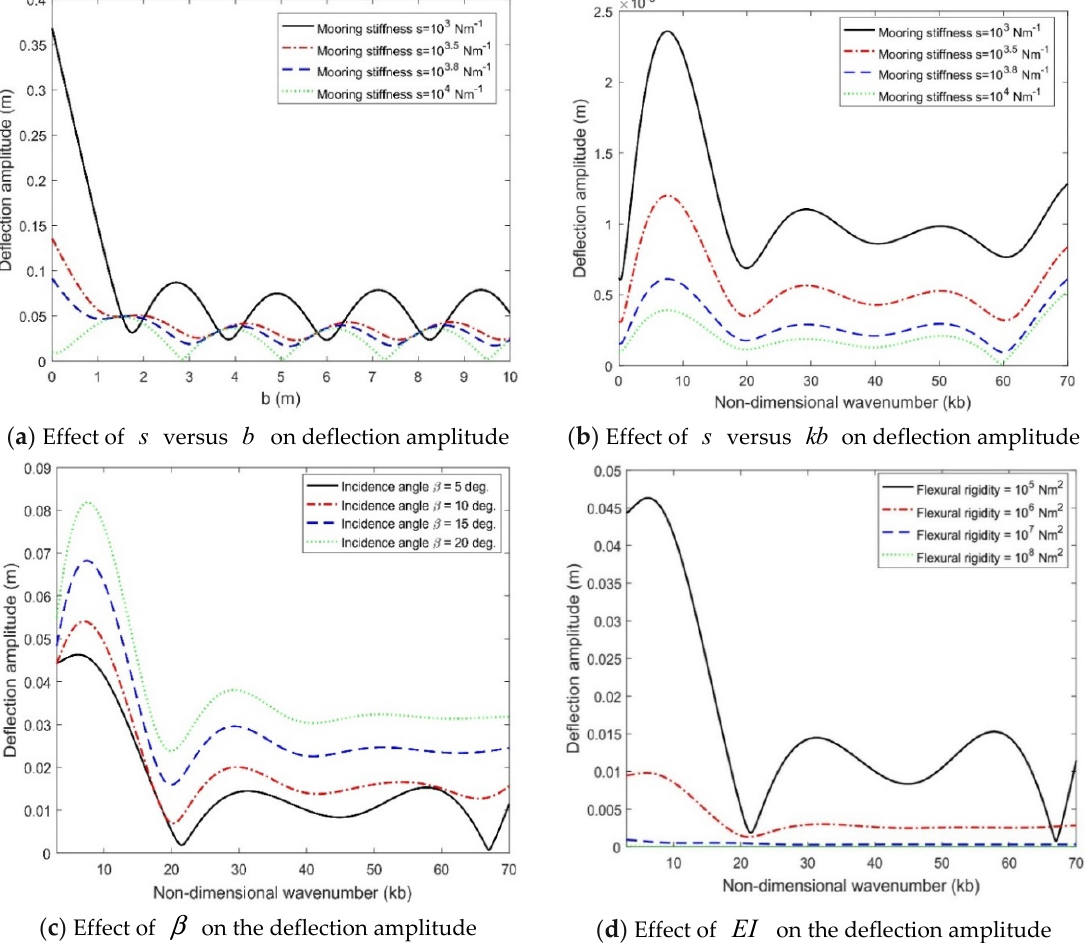
β with 3.5 − = , and ( d ) flexural rigidity with (cid:112) EI ρ g , and b / h =